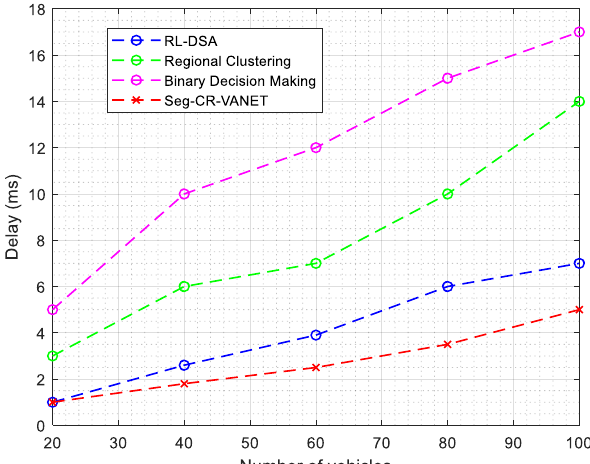
Figure 12. Comparison of delay.